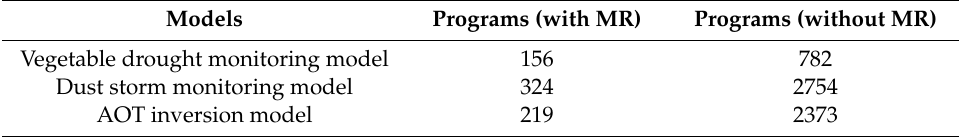
Table 3. SLOC of three typical disaster-monitoring models.